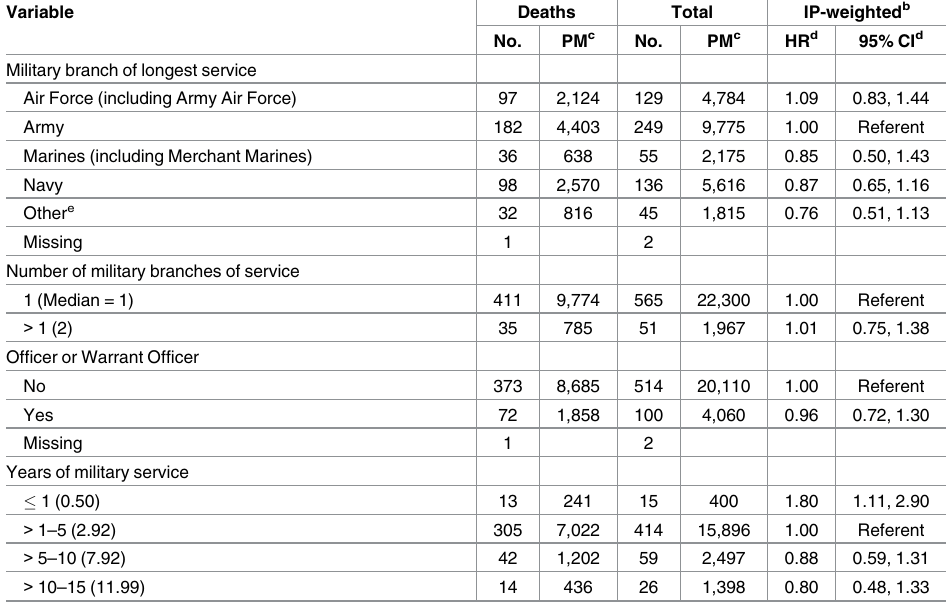
Table 3. Military serviceand amyotrophic lateral sclerosis survival in GENEVA a , United States of America, 2005–2013.